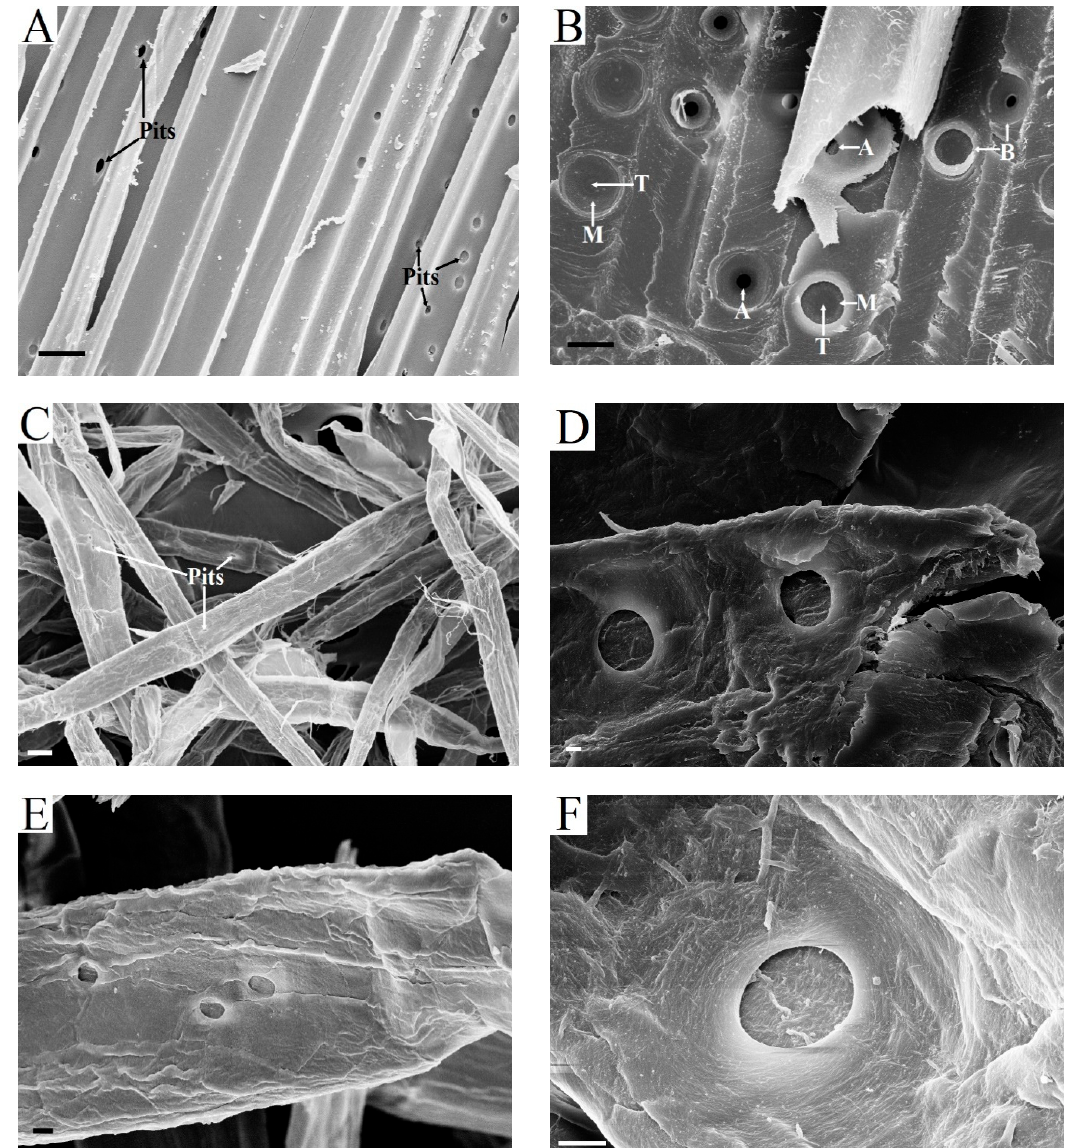
Figure 6. Pits of wood and kraft pulp fibers: ( A ) simple pits in libriform fibers; ( B ) bordered pits in tracheids of conifers; ( C ) pits in hardwood kraft pulp fibers; ( D ) pits in fibers of softwood kraft pulp after 3 h of enzymatic hydrolysis; and, ( E ) pits in fibers of hardwood kraft pulp after 3 h of enzymatic hydrolysis; ( F ) pit in fiber of softwood kraft pulp after 5 h of enzymatic hydrolysis. A—aperture, B—border, BP—bordered pit, M—margo, T—torus. Bars: A, B, C—10 μ m; D—1 μ m; E, F—2 μ m.